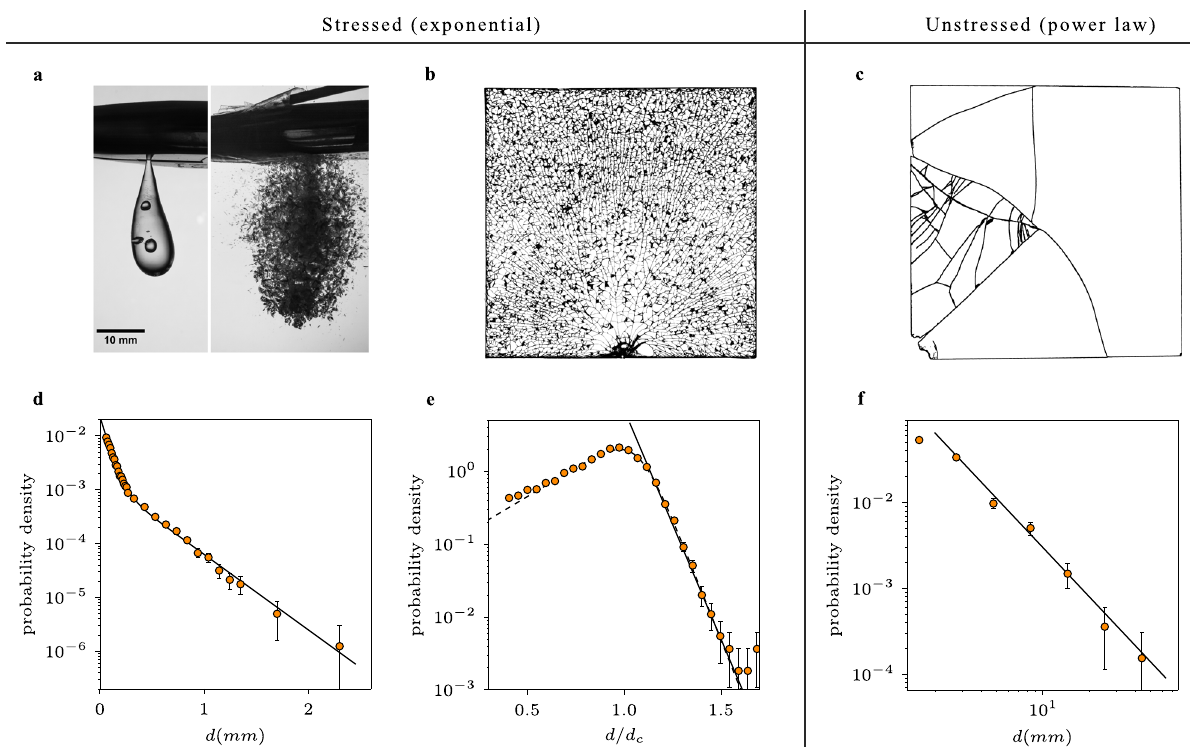
Fig. 1 Fragment size distributions of stressed and unstressed materials. The error bars in the graphs represent one standard deviation and are inferred by viewing the binning as a Bernoulli process. a Photograph of a Prince Rupert ’ s drop clenched by a plier (left), and the fragmentation of a (different) Prince Rupert ’ s drop triggered by cutting the tail with the plier (right). See Supplemental Information for a high-speed movie of the fragmentation of a droplet. b Tempered glass plate fractured by impact on one of its sides. For illustrative purposes the back of this particular plate is covered by adhesive tape so fragments are still fi xed together after fragmentation, showing the crack pattern. c Fragmented unstressed glass plate, with the big fragments puzzled back together after fragmentation. The sizes that range from the size of the system all the way down to tiny fragments, illustrate well the power-law behavior in this case. d Fragment size distribution of the Prince Rupert ’ s drop shown in a , where d is the equivalent spherical diameter. One drop fragments in at least 21,847 fragments, measured by micro-CT. Two exponential regions can be identi fi ed, which indicates inhomogeneous fragmentation. The solid line is a fi t of the form p ð d Þ (cid:2) C 1 exp ð(cid:3) d = d 1 Þ þ C 2 exp ð(cid:3) d = d 2 Þ , with d 1 = 0.31 mm and d 2 = 0.064 mm. The smallest fragments are what in most other experiments is referred to as the “ remaining dust ” . e Fragment size distribution of the tempered glass plates shown in b rescaled by d c for each plate thickness, where d c is the characteristic length set by the location of the maximum. The distribution is a truncated exponential distribution (as indicated by the solid line) with an exponential cutoff at a characteristic length set by d c . The dotted line is a generalized logistic distribution, fi tting the full distribution well. f Fragment size distribution of two unstressed glass plates, where the solid line is a power-law fi t with an exponent of 1.9. Source data are provided as a Source Data fi